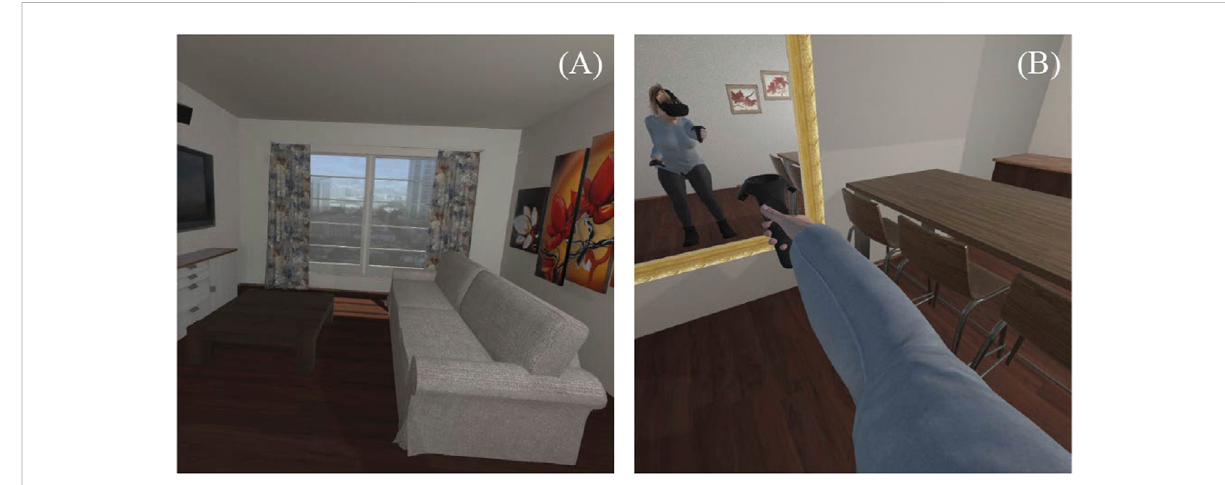
FIGURE 1 Depictionofthevirtual environmentfromtheparticipant ’ sperspective. Note. (A) Virtualenvironmentonparticipant ’ sleft, (B) Participant ’ spoint of view when looking at one ’ s virtual